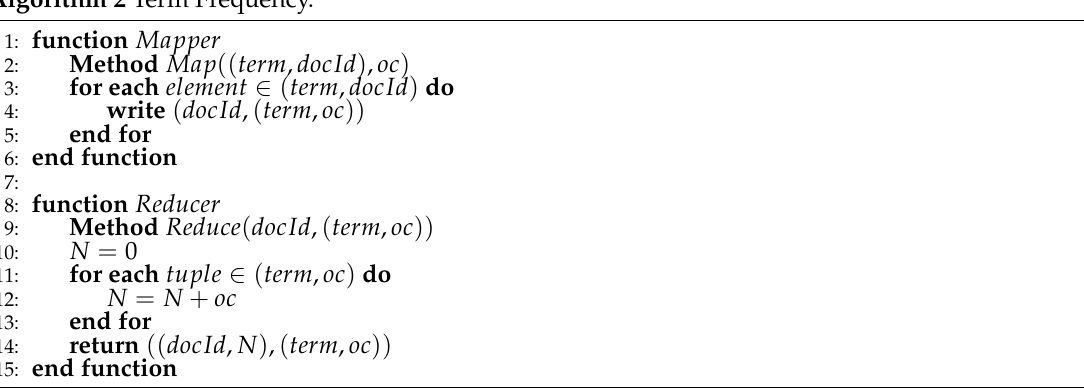
Algorithm 2 Term Frequency.